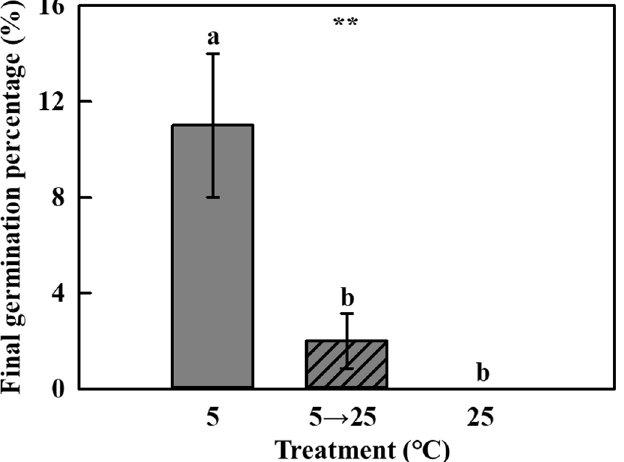
Figure 4. Final germination percentage of coastal glehnia seeds after 11 weeks of cold (5 ◦ C) or warm (25 ◦ C) stratification treatment, and cold stratification for five weeks before being moved to warm stratification treatment (5 → 25 ◦ C). The vertical bars indicate standard errors. Different letters showed significant differences. ** indicates significance at p < 0.01 ( n =